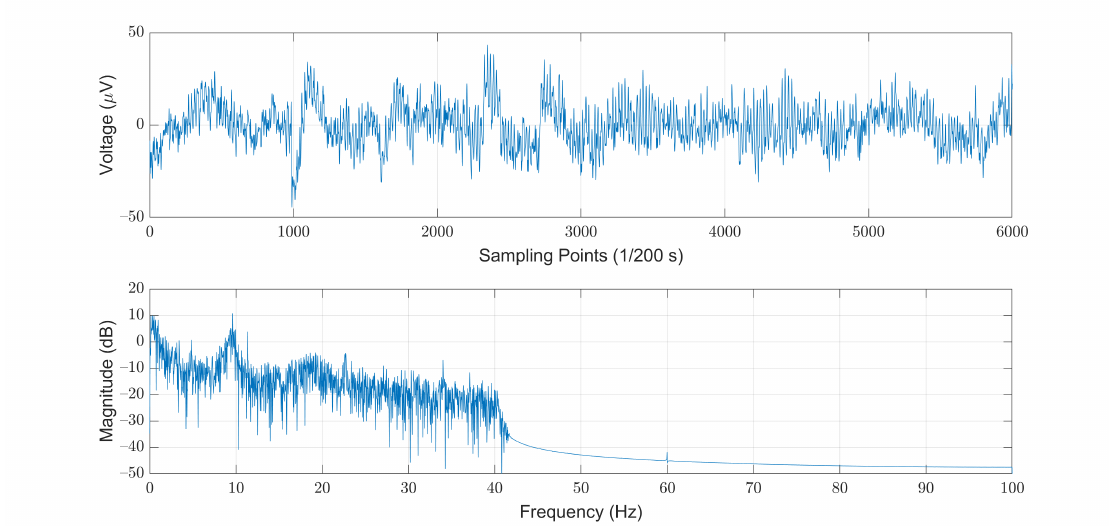
Figure 4. The low-pass filtered EEG signals illustrated in time ( top ) and frequency ( bottom )